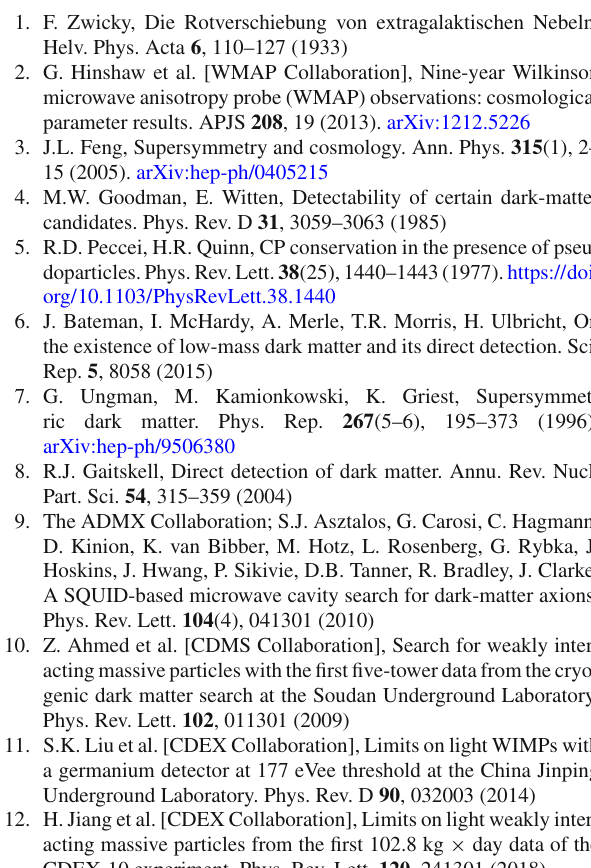
extending the fitted empirical trend as a function of applied electric field by more than two orders of magnitude beyond the data. Therefore, the discussion above needs to be verified using experimental data in the